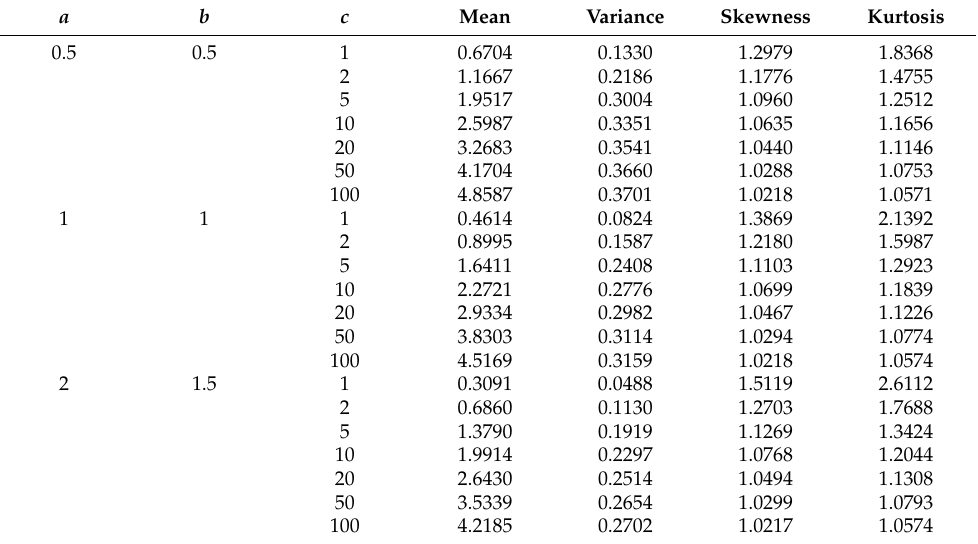
Table 1. Mean, variance, skewness and kurtosis of the GOLE-E distribution with different values of a , b , c and λ =